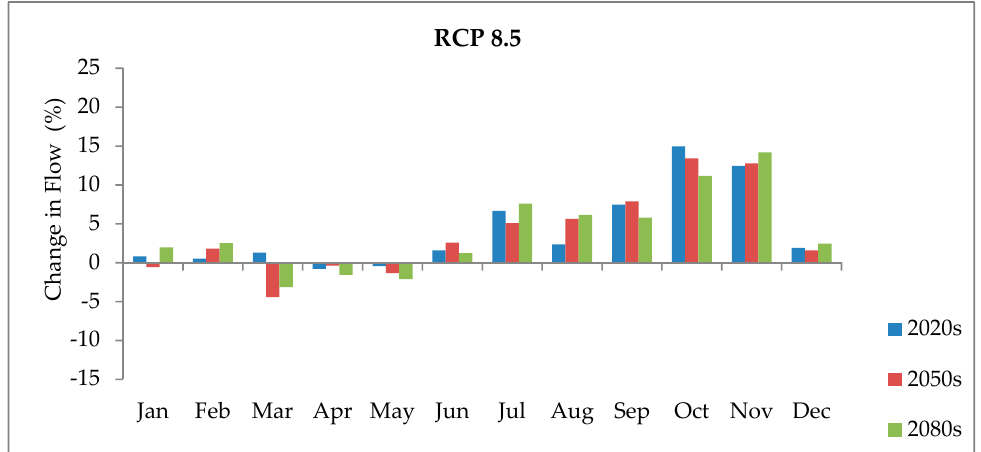
Figure 16. Change in stream flow under RCP 8.5 scenarios compared to the baseline period (1961– 1990).